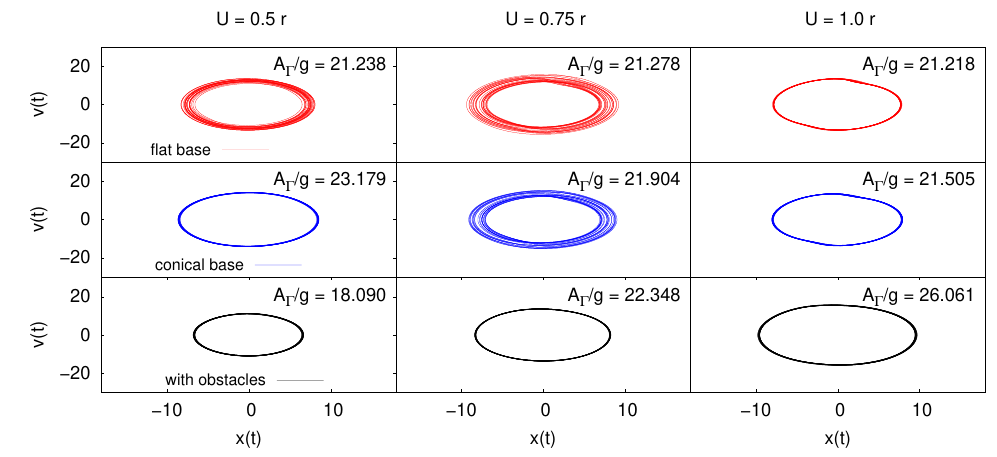
Figure 4. Phase diagram for the di ff erent GDs at U = 0 . 5 , 0 . 75 and 1 . 0 r